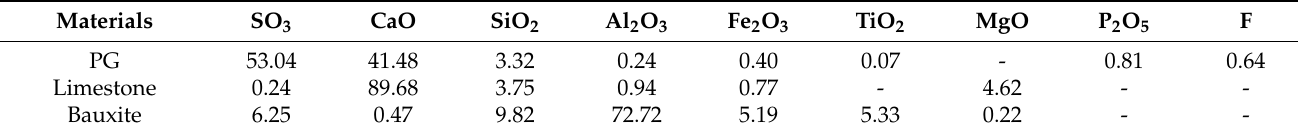
Table 1. Chemical compositions of the materials (wt %).